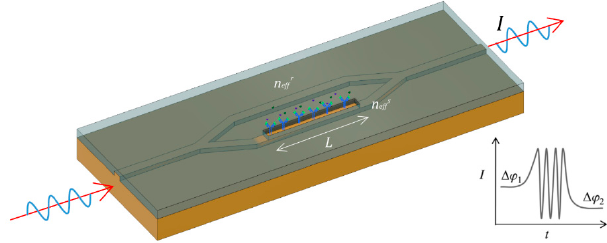
Figure 2. Standard integrated MZI and interferometric output.